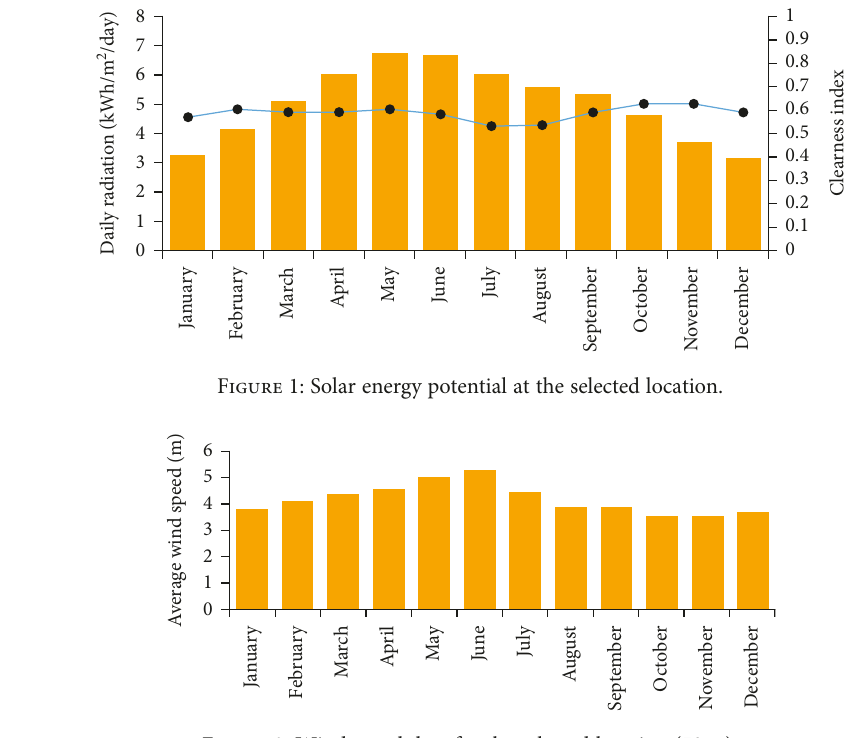
Figure 2: Wind speed data for the selected location (50 m). Table 1: Load estimate of a typical rural house in